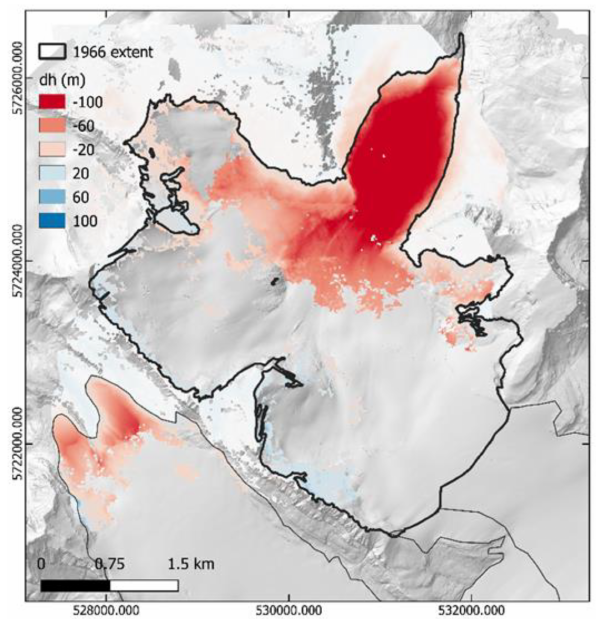
Figure 18. Elevation change over Peyto Glacier, 1966–2017, inside the IHD glacier